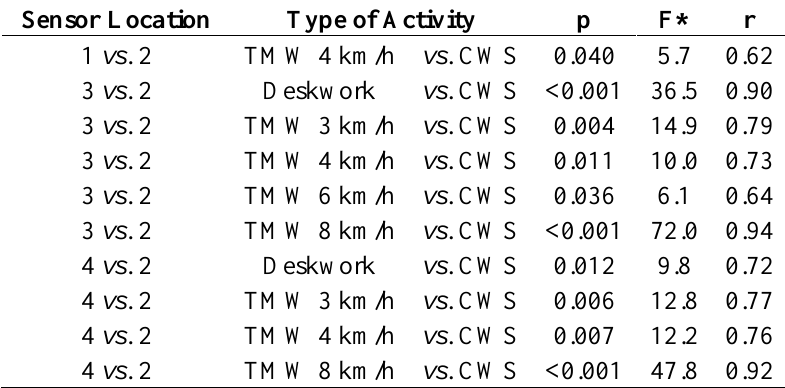
Table 5. Overview of all significant interaction effects. Contrasts for sensor locations to their baseline sensor location 2 and types of activities to their baseline CWS.